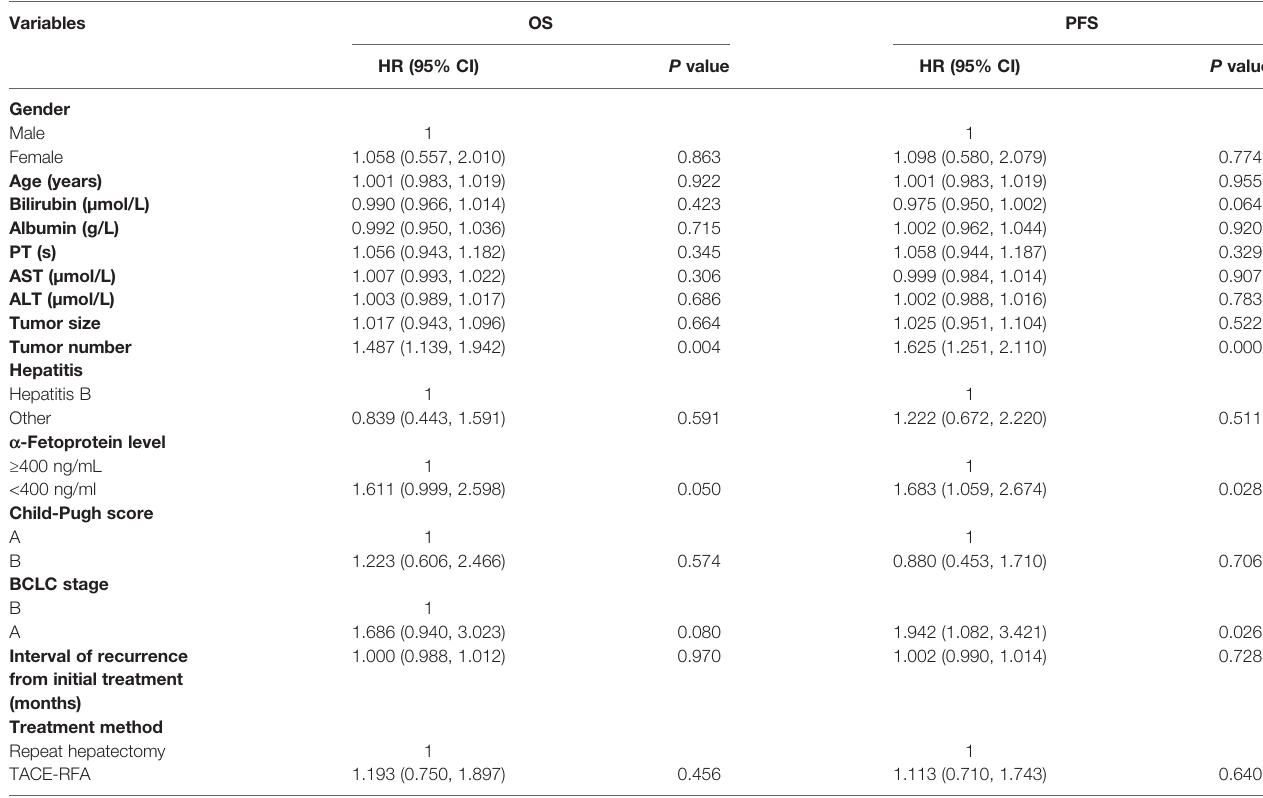
TABLE 2 | Univariate analysis of prognostic factors for overall survival and progression-free survival. Variables